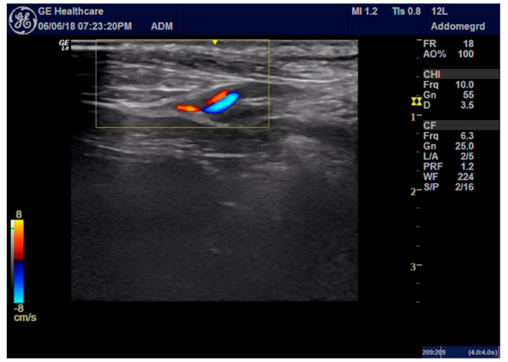
Figure 2. The anaesthetised spermatic cord at the superficial inguinal ring is shown.